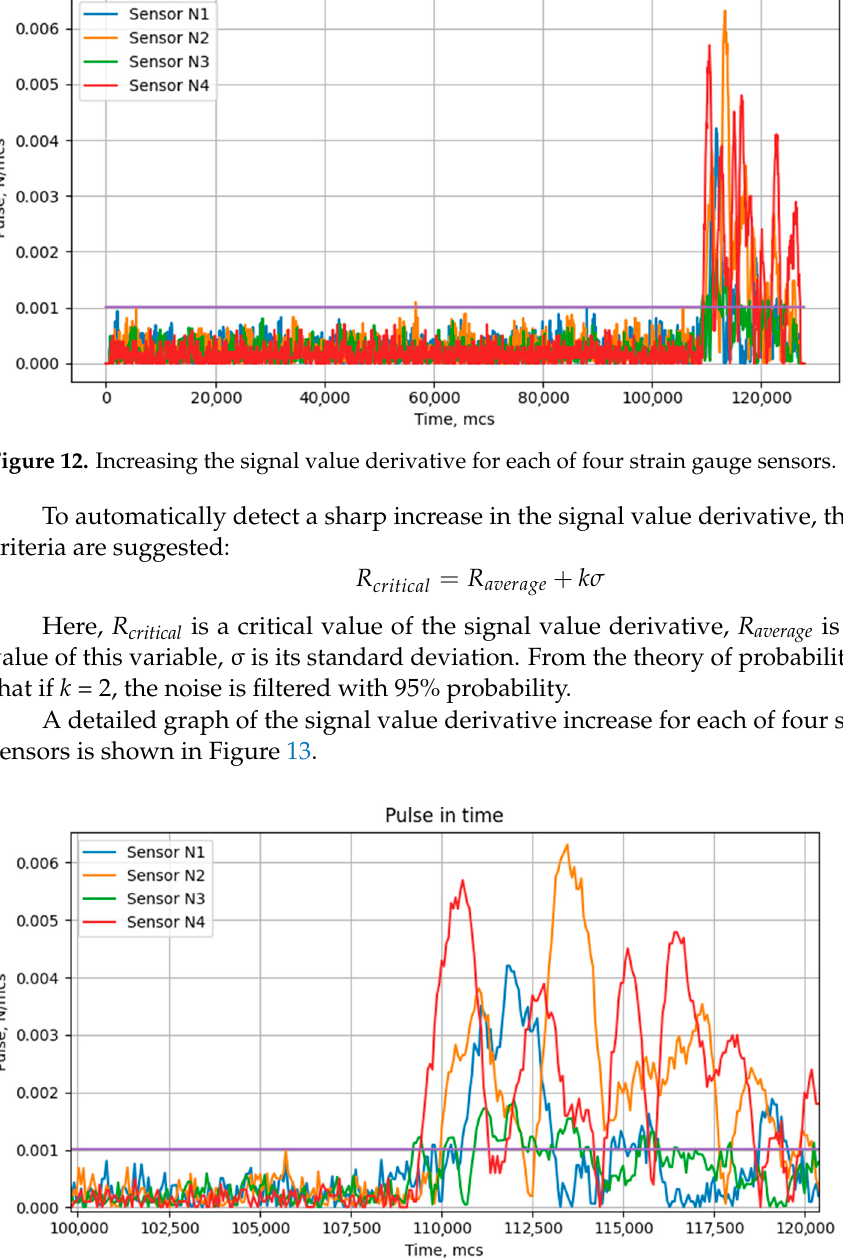
Figure 11. Dynamic load in time for each of four strain gauge sensors.